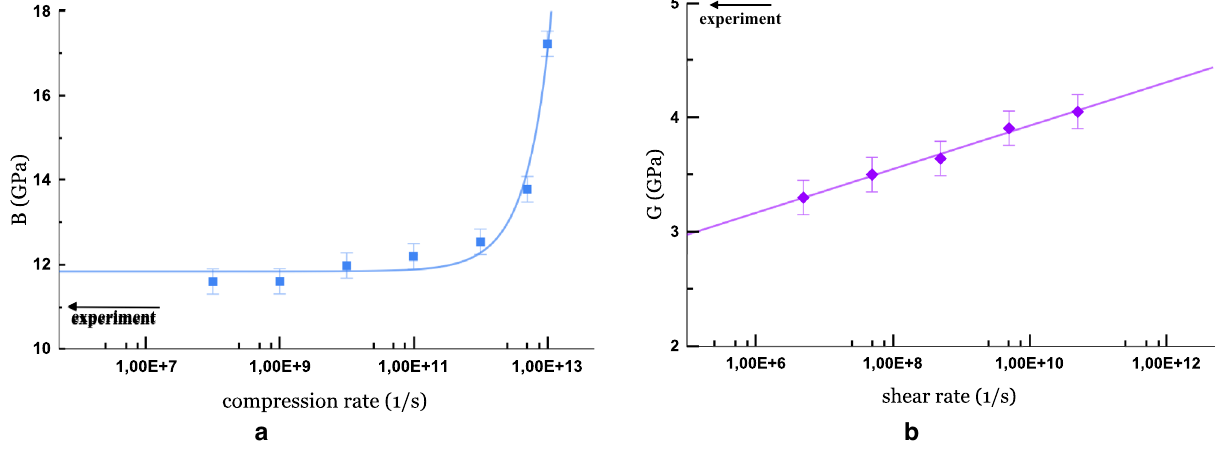
Figure 2. The dependence of elastic moduli of HDA on the relative strain rate for small deformation. ( a ) The compression rate dependence of the bulk modulus at T = 77 K and P = 0.17 GPa ; the solid blue line shows an exponential interpolation. ( b ) The shear rate dependence of the shear modulus at T = 77 K and P = 0.05GPa ; the solid purple line shows a logarithmic interpolation. The abscissa axis is in the logarithmic scale. The experimental values 30 are shown by